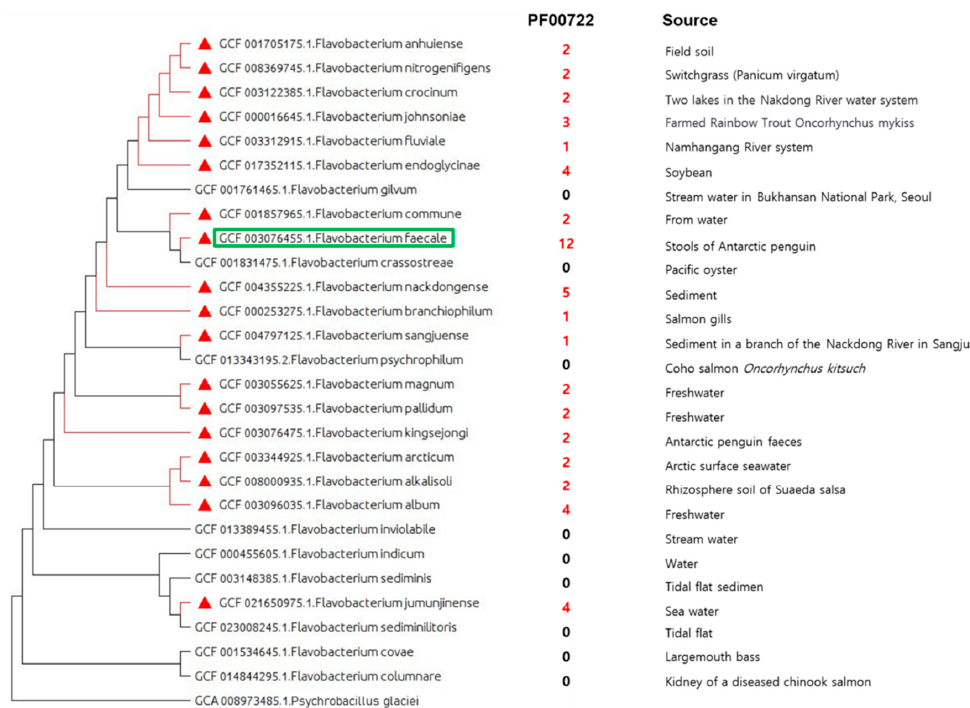
Figure 5. Phylogenomic analysis of 27 Flavobacterium strains including F. faecale WV33 T . Phylogenetic tree was generated using GToTree and the red triangle represents the presence of predicted agarase (Pfam:PF00722). The numbers on the right represent abundance of Pfam:PF00722 (=GH16) in genomes of 27 Flavobacterium strains. Green box represents F. faecale WV33 T (GCF 003076455.1). Psychrobacillus glaciei (GCA_008973485.1) was used as an outgroup to root the tree.